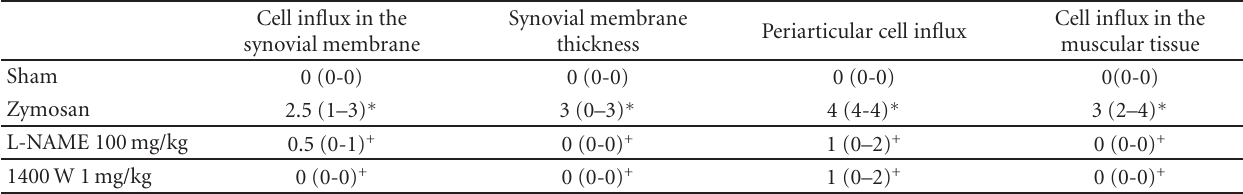
Periarticular cell influx